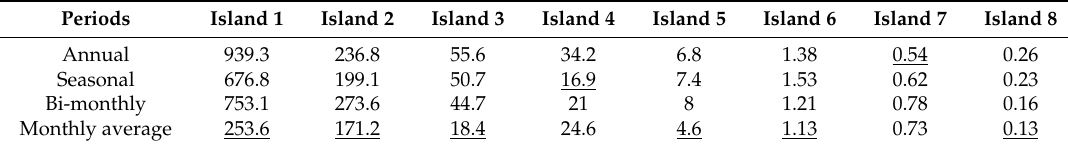
Table 4. Analysis of similarity for load pattern estimation methods with different periods